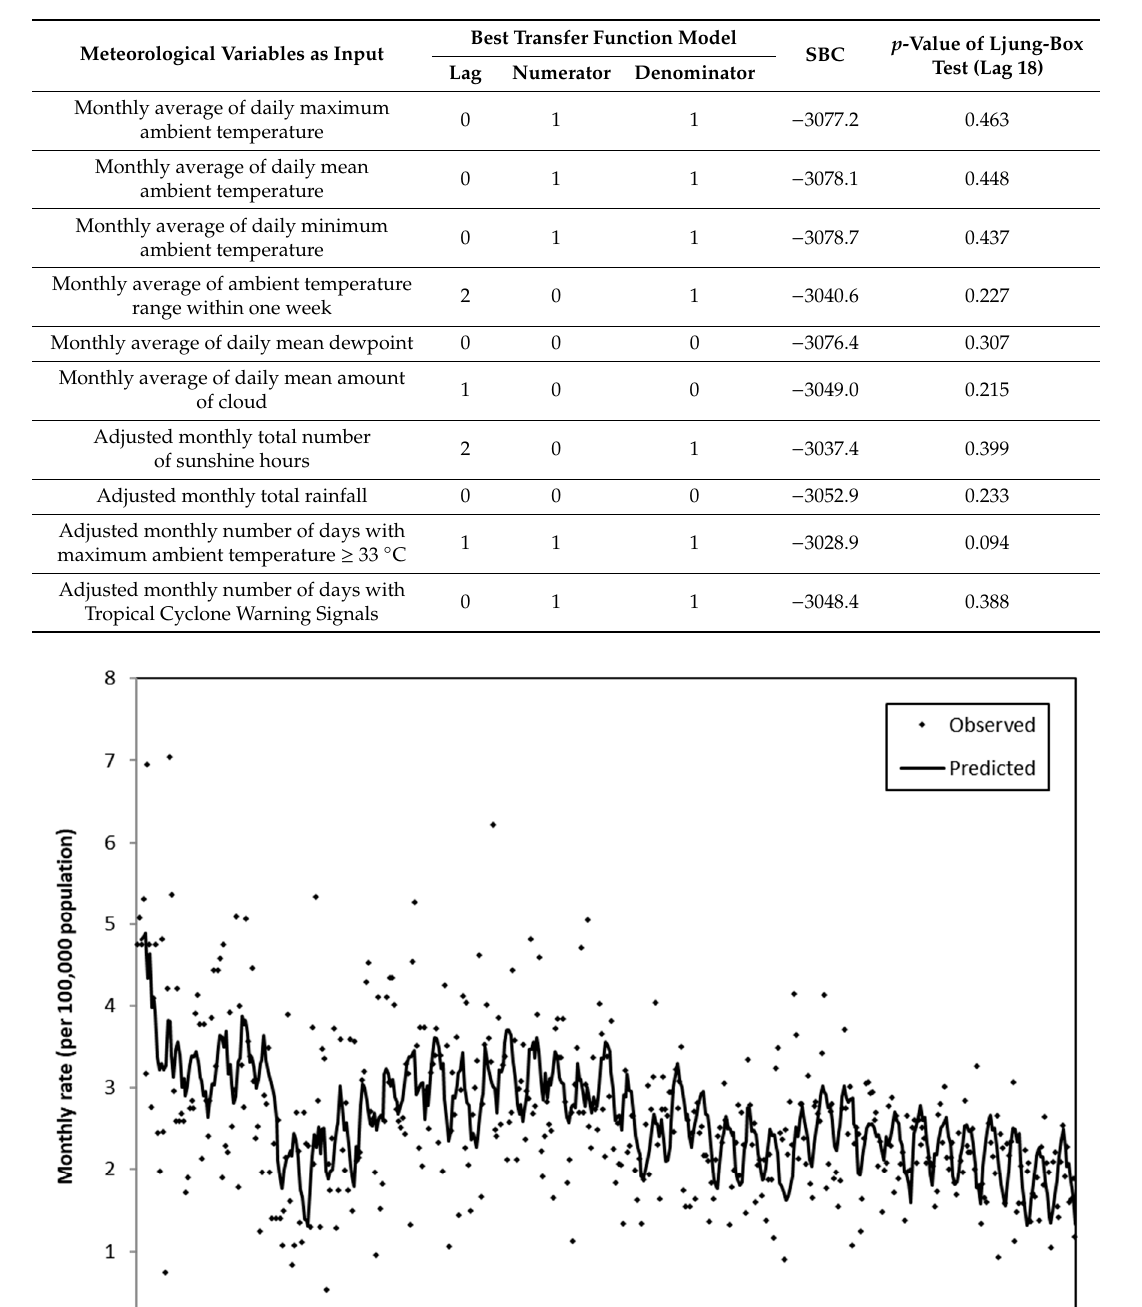
Table 3. Transfer function models for the rate of older-adult suicide deaths from violent methods.